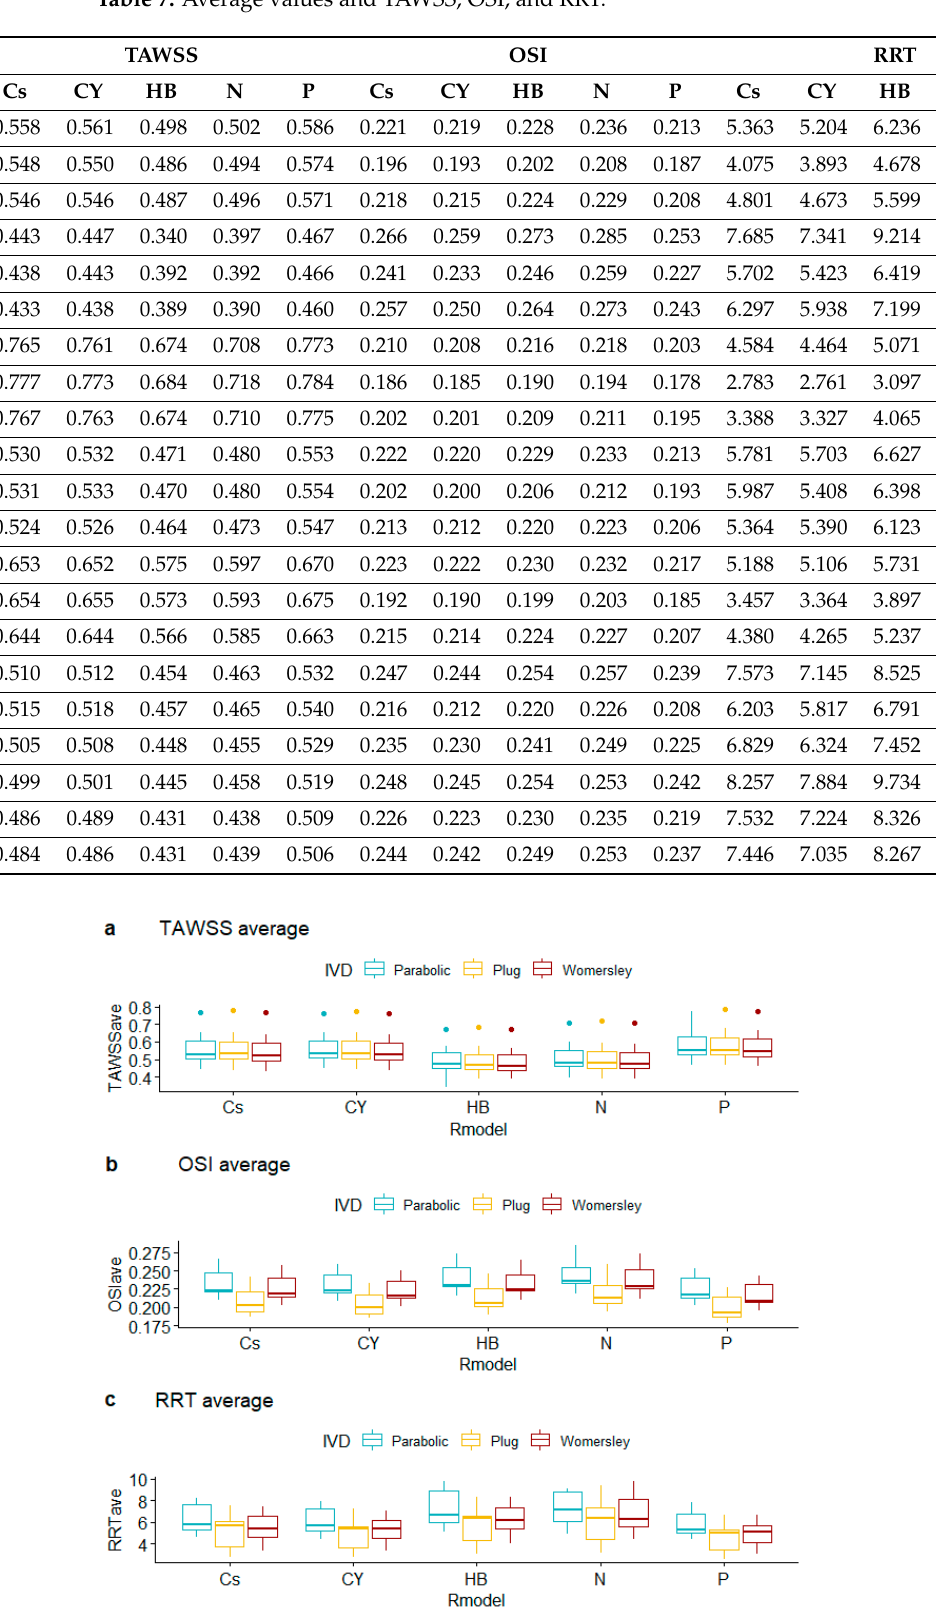
Table 7. Average values and TAWSS, OSI, and RRT.